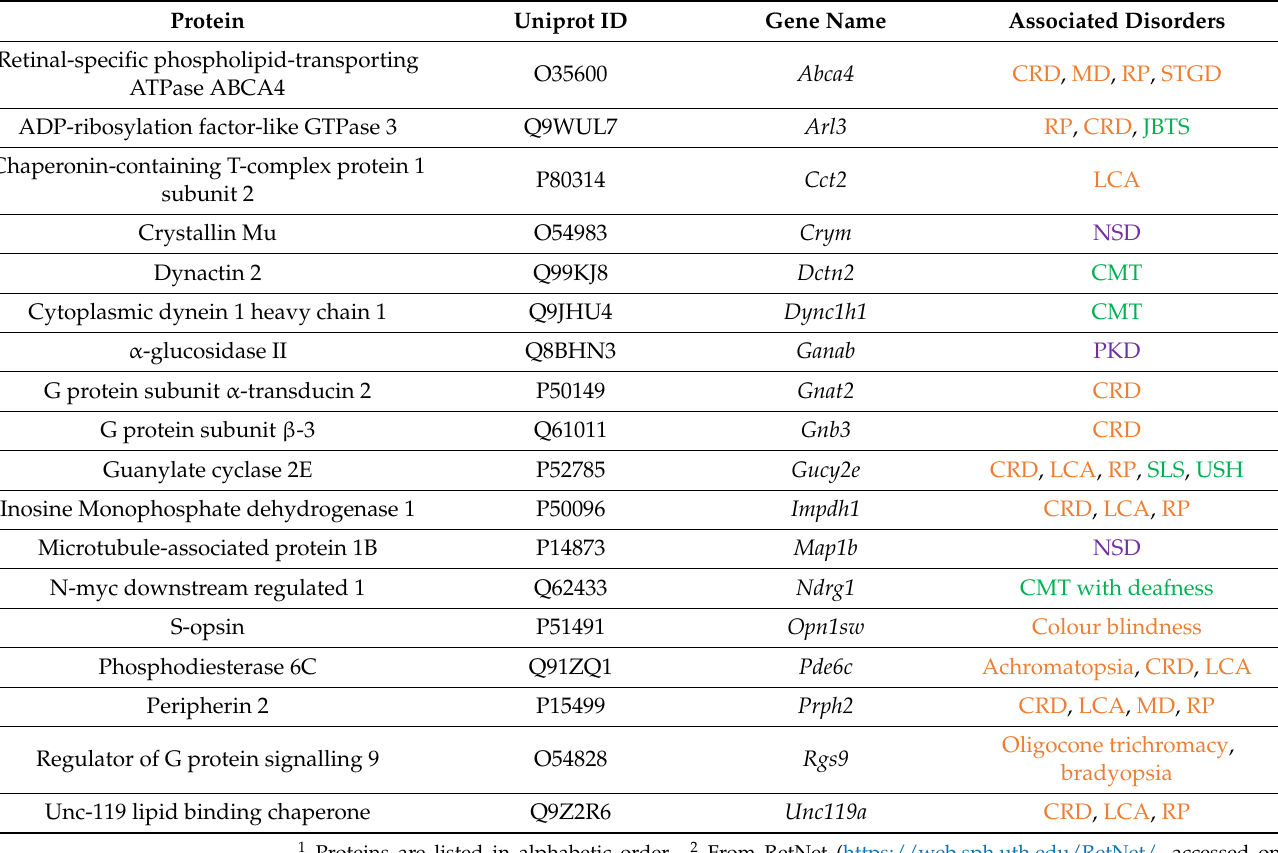
Table 1. List of USP48 interactors causative of IRDs and/or ciliopathies, indicating Uniprot ID,